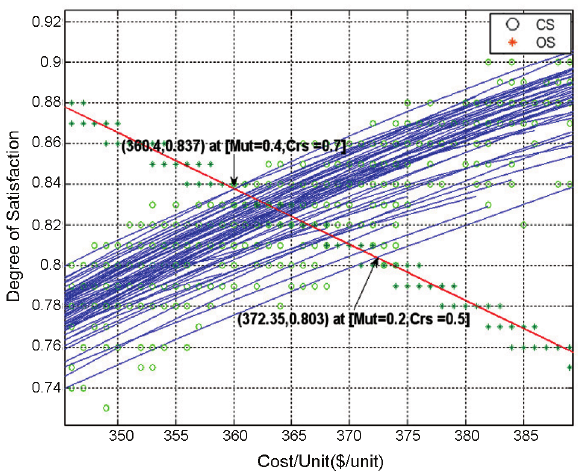
Fig. 4. Zoom-in view of the dotted box in Figure